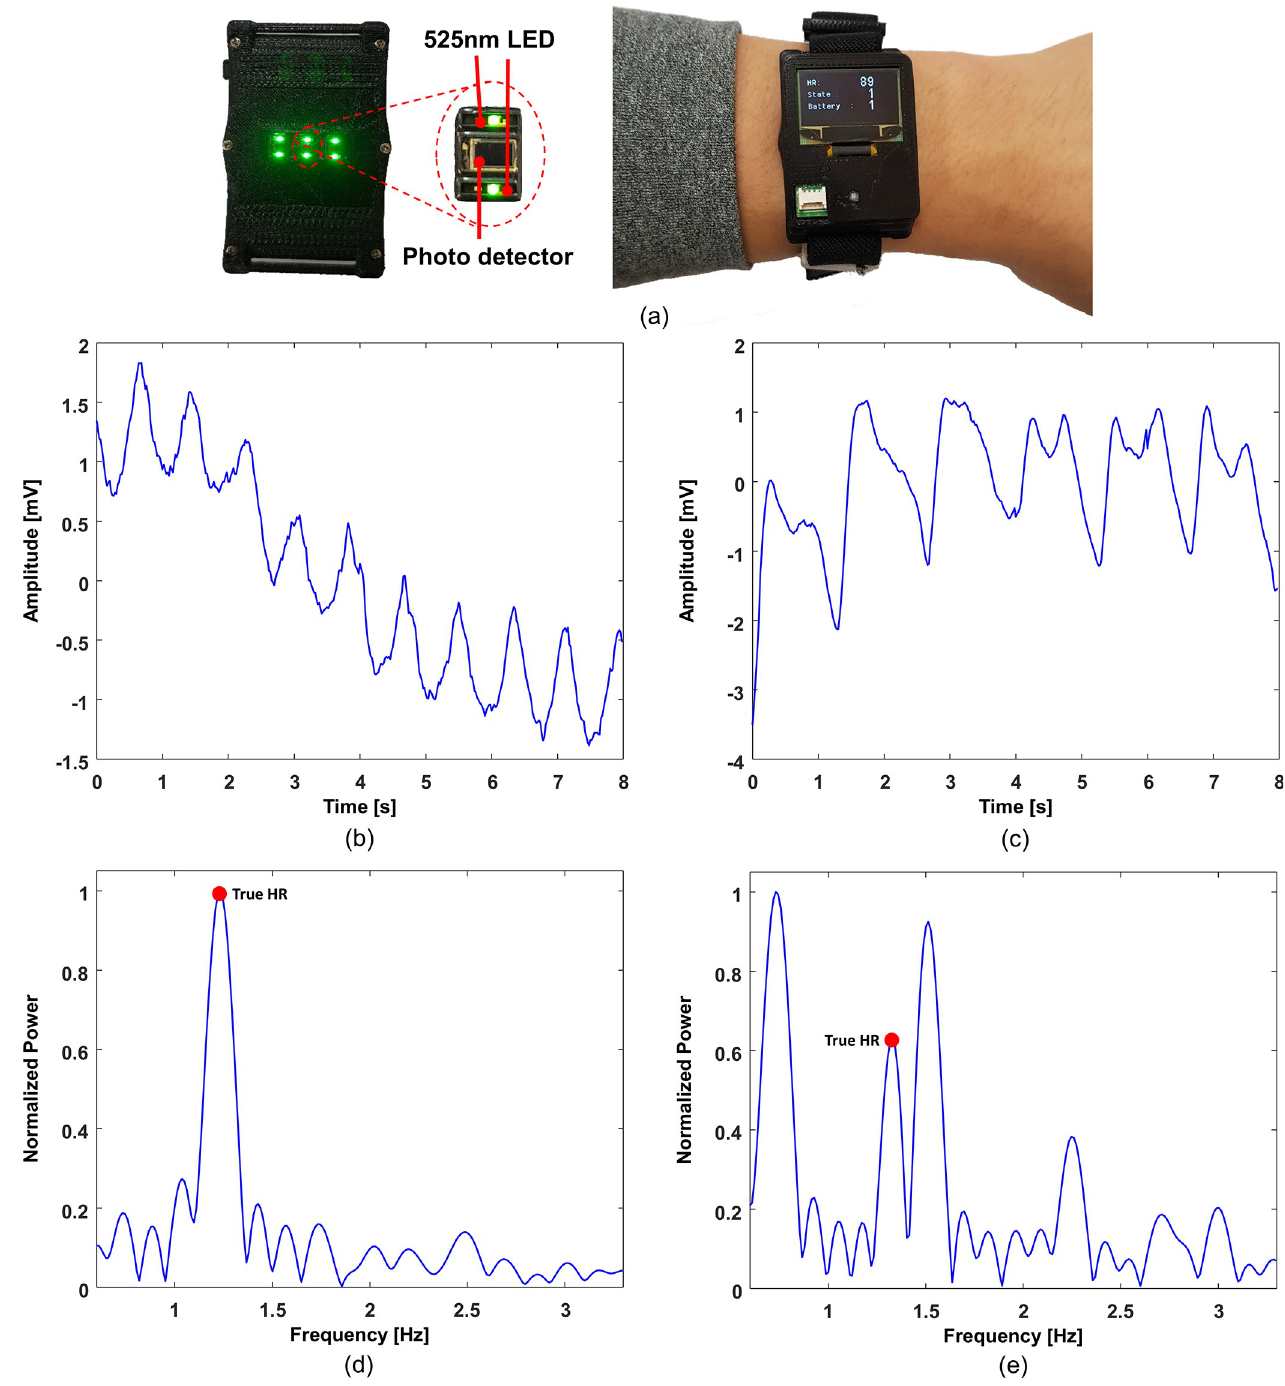
Fig 1. Wearable BAMI device for acquiring three-channel PPG signals and three-axis acceleration signals. (a) device, (b) example of measured PPG signal corrupted by low-intensity MAs, (c) example of measured PPG signal corrupted by high-intensity MAs, (d) power spectrum of signal (b) with true HR, and (e) power spectrum of signal (c) with true